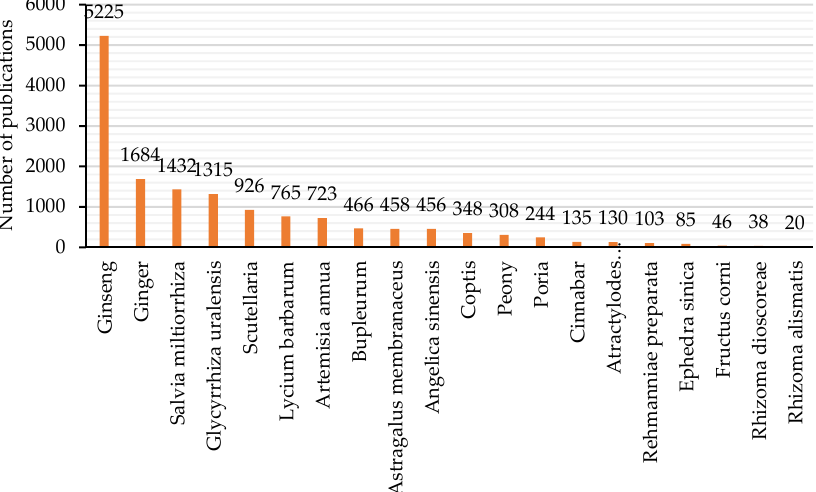
Figure 4. Total number of publications per herb in PubMed, using the article’s title as the searching criteria.